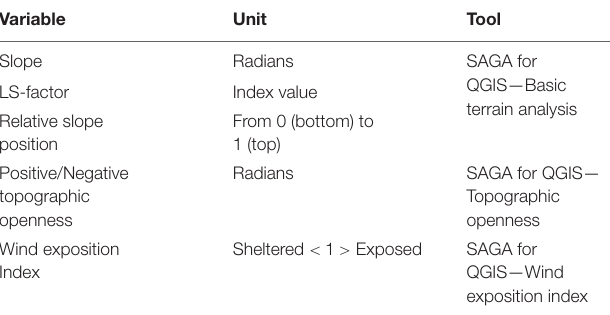
TABLE 1 | Description of topographic derivative layers calculated from multibeam echosounder (MBES) bathymetry, using the SAGA for QGIS Tools (Conrad et al.,